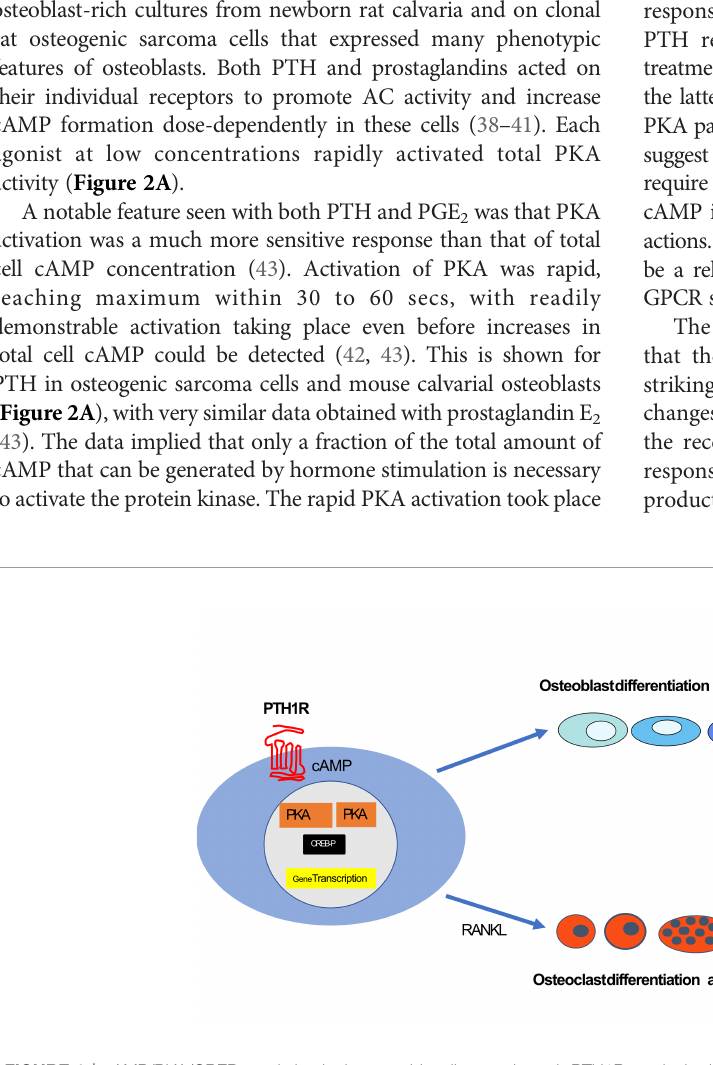
FIGURE 1 | cAMP/PKA/CREB regulation in the osteoblast lineage through PTH1R results in directions along two main pathways. These can be direct effects on osteoblast differentiation and activity throughout the osteoblast lineage leading to increased bone formation, and indirect effects on osteoclast formation from precursors and their activity, mediated by RANKL production (see